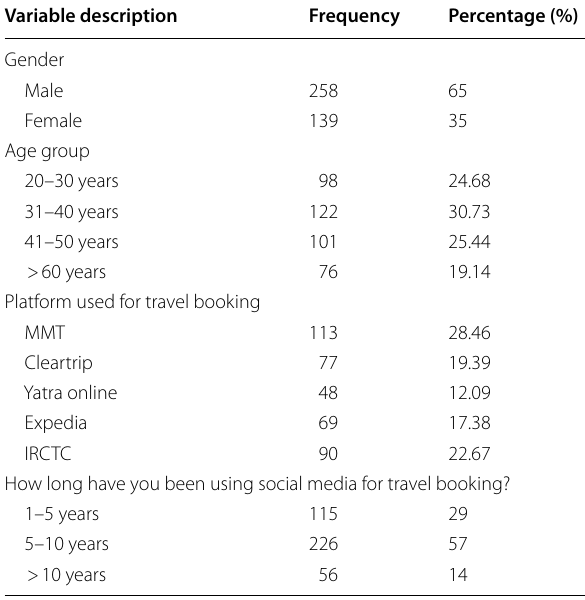
Table 1 Demographic profile Source : Primary data Variable description